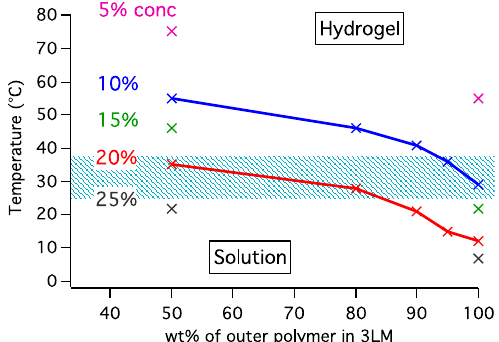
Figure 5. Summary of so-to-gel phase diagram.